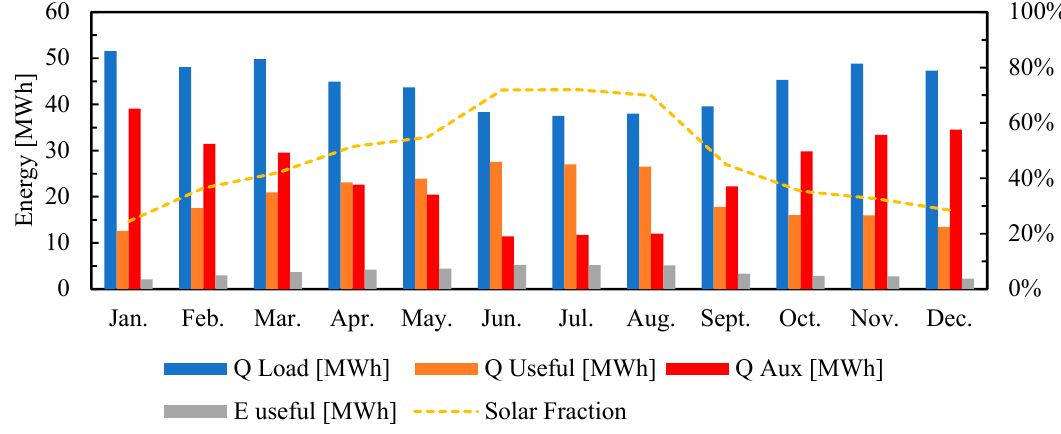
Figure 2. Monthly thermal (Q Useful) and electrical (E useful) yields of the solar hybrid plant, thermal demand (Q Load), auxiliary heat (QAux), and solar fraction (Source: Author’s own calculation).